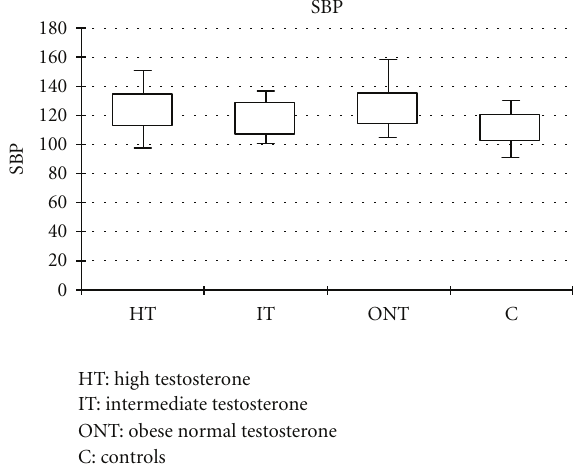
Figure 1: Systolic Blood Pressure—distribution among the groups. HT: High Testosterone, IT: Intermediate Testosterone; ONT: Obese Normal Testosterone; C: Controls.